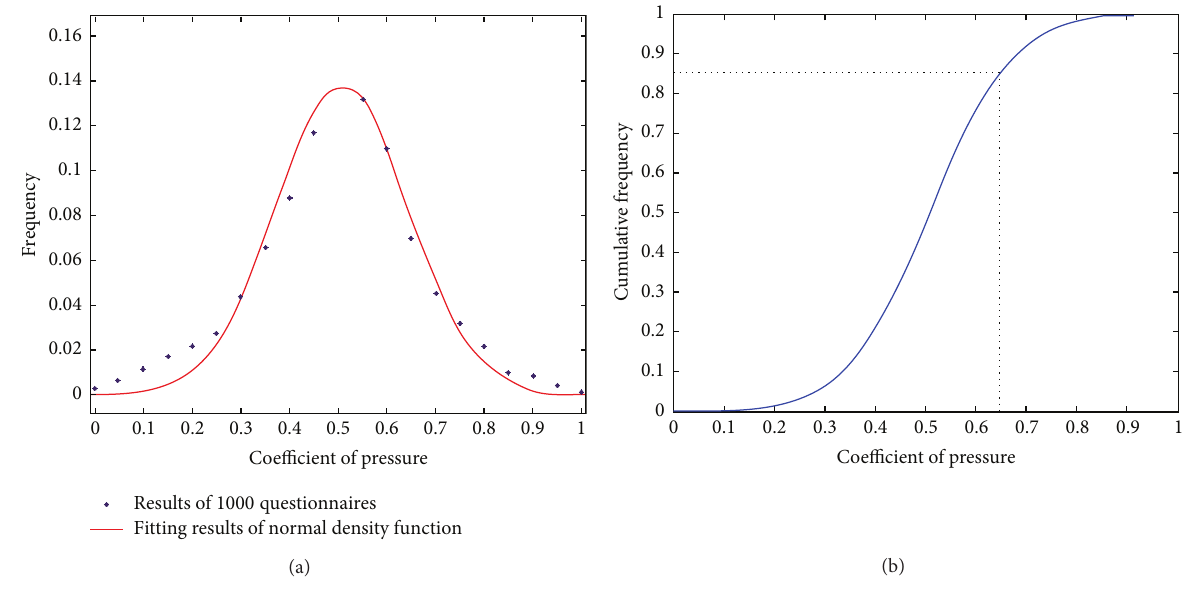
Figure 2: Evaluation results of pressure coefficient in traffic congestion. Table 1: Indexes of drivers’ visual characteristics in general and congested